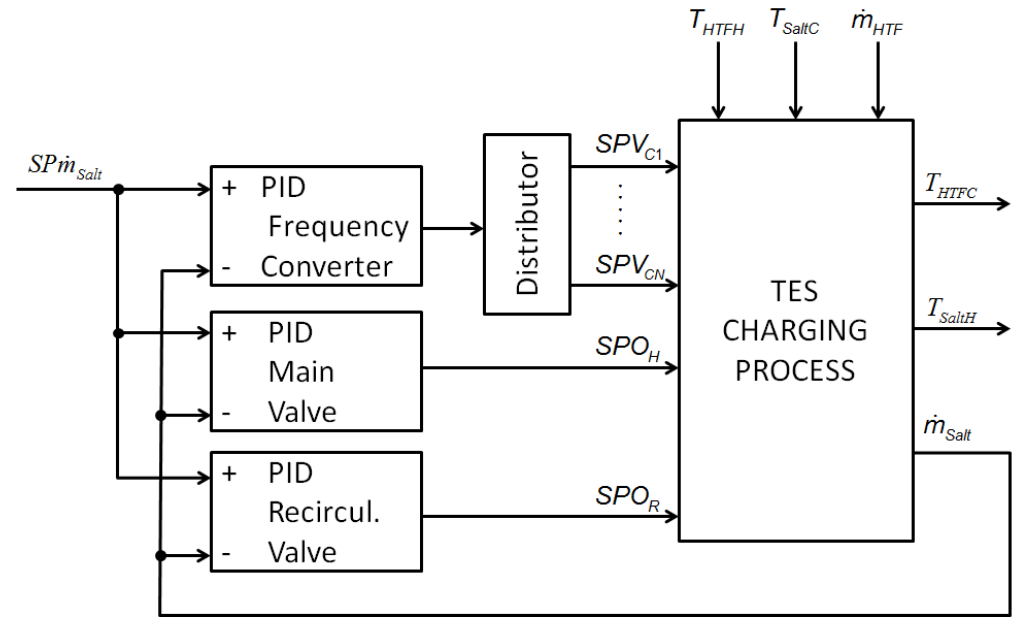
Figure 10. Semiautomatic control of a TES charge